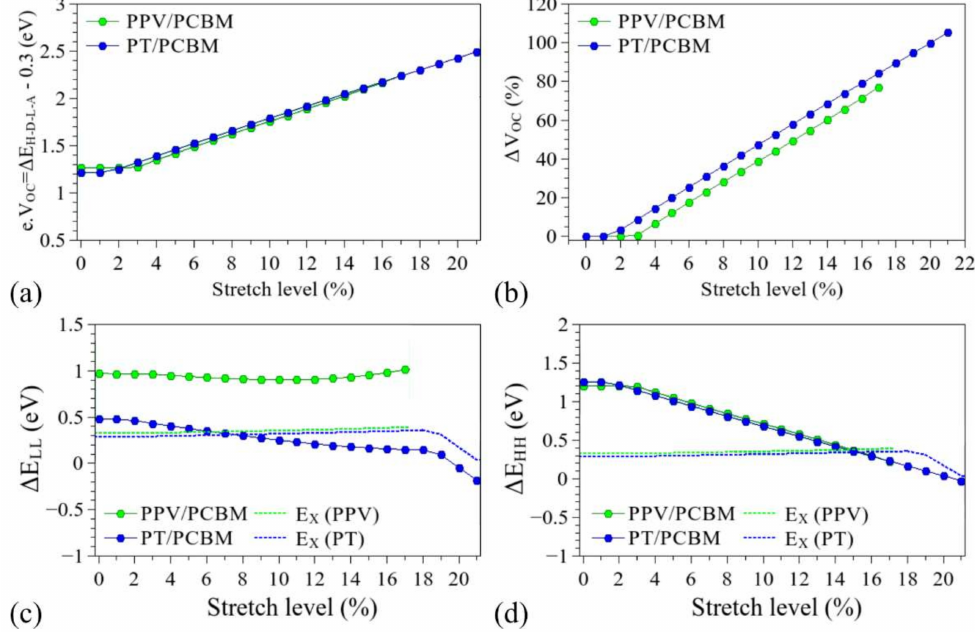
Figure 15. Evolution of the parameters ( a ) V OC , ( b ) ∆ V OC , ( c ) ∆ E LL , and ( d ) ∆ E HH during the stretching processes for PCBM-based